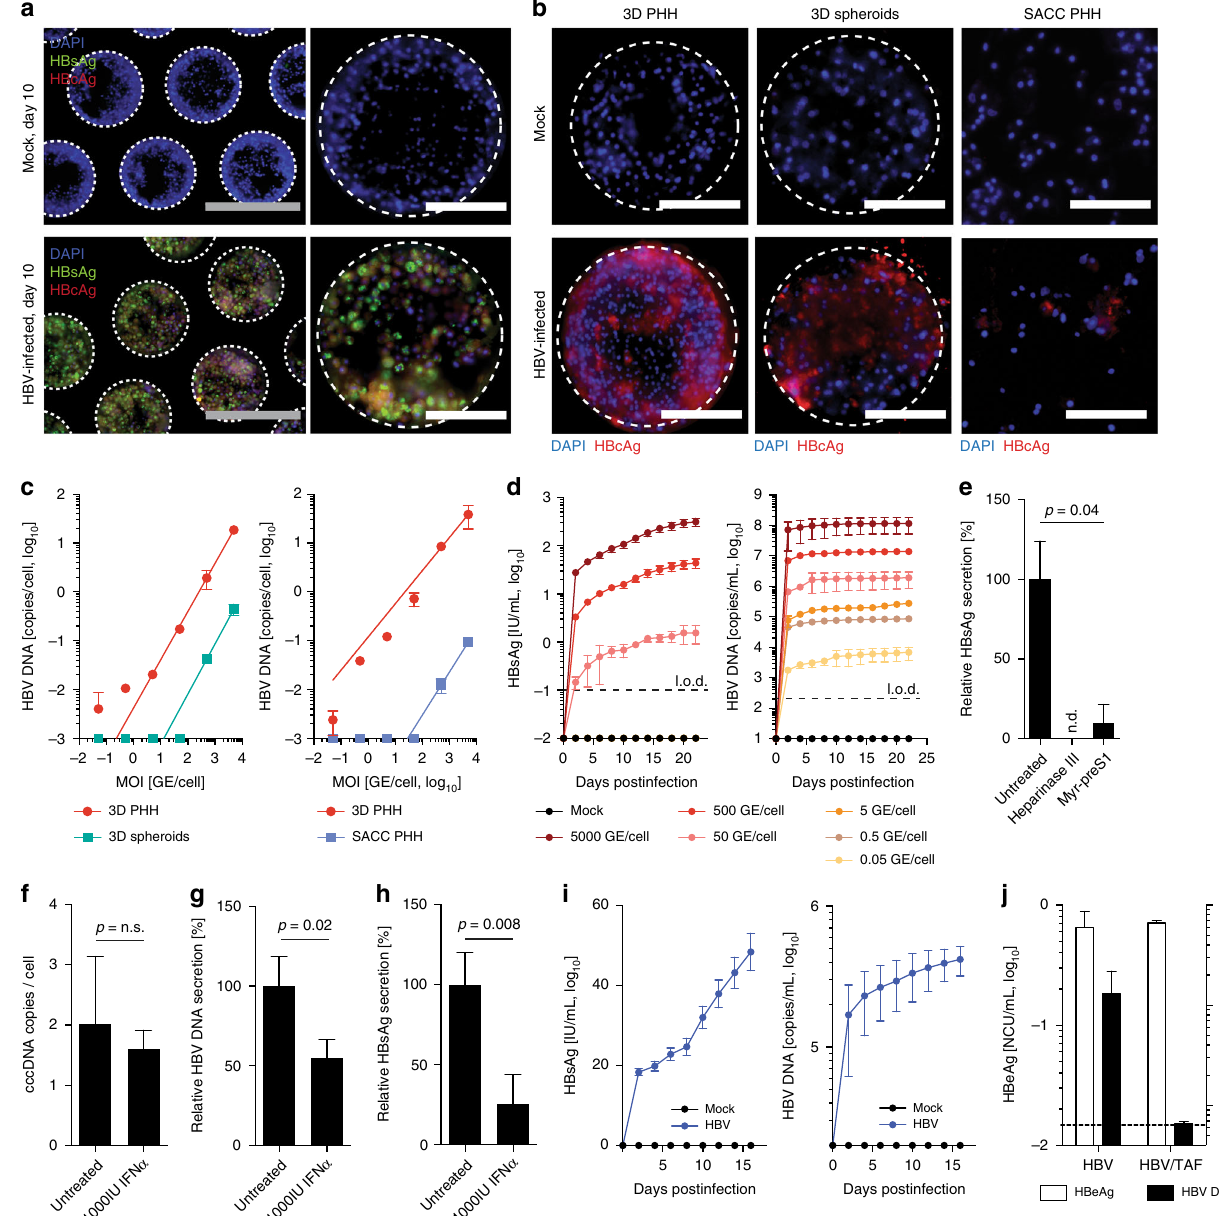
Fig. 3 3D PHH cultures are susceptible to long-term HBV infection. a , b Immuno fl uorescence detection of a HBsAg and HBcAg 10 days following infection of 3D cultures with patient-derived HBV (100 GE/cell) and b HBcAg in 3D PHH cultures, 3D spheroid cultures, and SACC PHH cultures 12 days following infection with HepDE19-derived sucrose-puri fi ed HBV (500 GE/cell). c Susceptibility of 3D PHH cultures compared to 3D spheroid cultures (left) and SACC PHH cultures (right) following infection with HepDE19-derived, sucrose-puri fi ed HBV at the indicated MOI via detection of secreted HBV DNA. d Longitudinal cumulative HBV DNA and HBsAg secretion following infection of 3D PHH cultures with the indicated MOI of sucrose gradient-puri fi ed HepDE19-derived HBV. e Blocking of HBV entry in 3D PHH cultures by pretreatment of cells with 5 U/mL heparinase III or myristoylated preS1 peptide (aa2-48, 1 μ M) for 1 h prior to infection with 500 GE/cell sucrose-puri fi ed HepDE19-derived HBV. HBsAg secretion was determined 6 days postinfection. f – h Response of HBV-infected 3D PHH cultures to treatment with recombinant IFN α (1000 IU/mL) as determined by quanti fi cation of f cccDNA copies per cell using quantitative PCR of Hirt-extracted DNA, secretion of g HBV DNA, and h HBsAg at 21 days postinfection. IFN α treatment was initiated 2 days postinfection and maintained throughout the culture period. i Longitudinal cumulative HBsAg and HBV DNA secretion following infection of 3D PHH cultures with 200 GE/cell of patient-derived HBV. j HBeAg and HBV DNA secretion of HBV-infected 3D PHH cultures (100 GE/cell) in the presence of 1